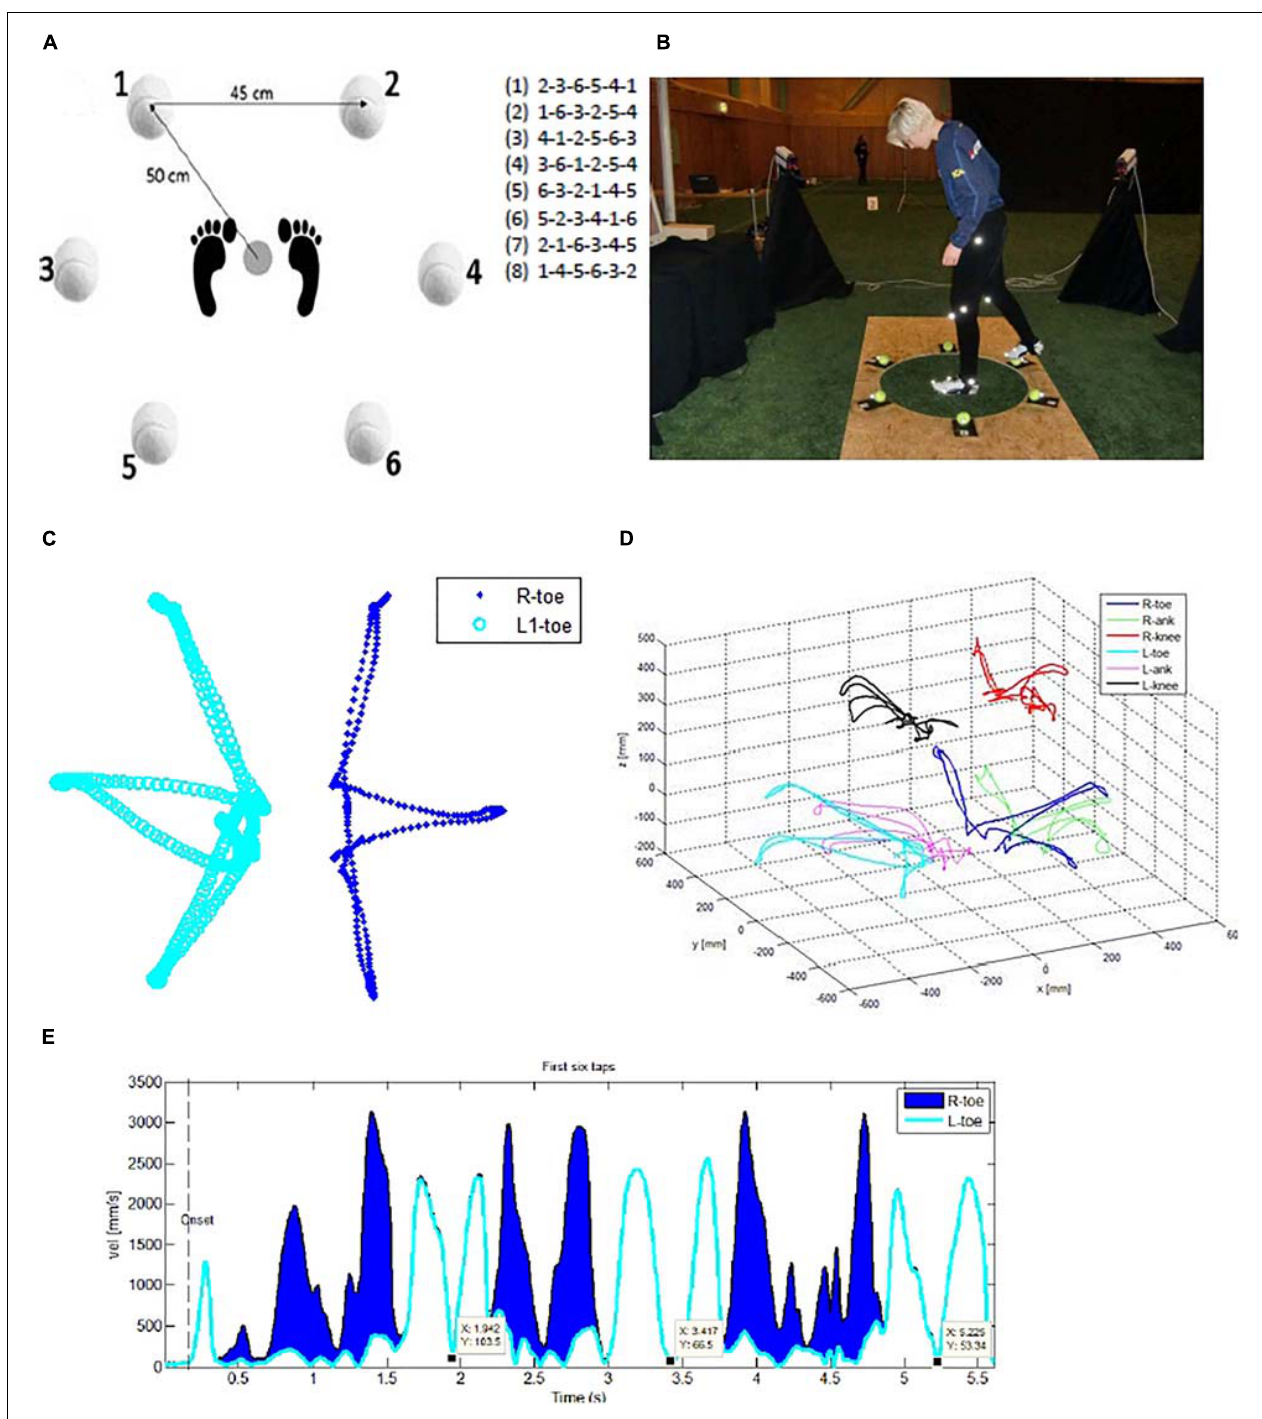
FIGURE 1 | Experimental of protocol illustrating (A) the stepping task set-up and example of the eight randomized digit series (e.g., task inducing cognitive-load), contra-balanced (by side), (B) photo illustrating the task condition and the marker set-up on the participant, (C) example of 2D (x, y) movement trajectories of the right and left foot during the first six step performance (duration 5.7 s) when matching the stepping with the cognitive loaded trial sequence (2/R – 3/L – 6/R – 5/L – 4/R – 1/L) with the actual time position of the three accurate left foot-taps added to the velocity trajectory, and (D) the 3D (x-, y-, z-plane) movement trajectories of the right/R and left/L toe, ankle, and knee, respectively, and (E) the corresponding velocity trajectories of the right and left toe movements, respectively. The black dots on the velocity trajectory (L-toe) donate the exact moments [time (x) and velocity (y)] of the respectively first three left-foot target hits. Written permission for publication of the photo (B) has been reserved from the